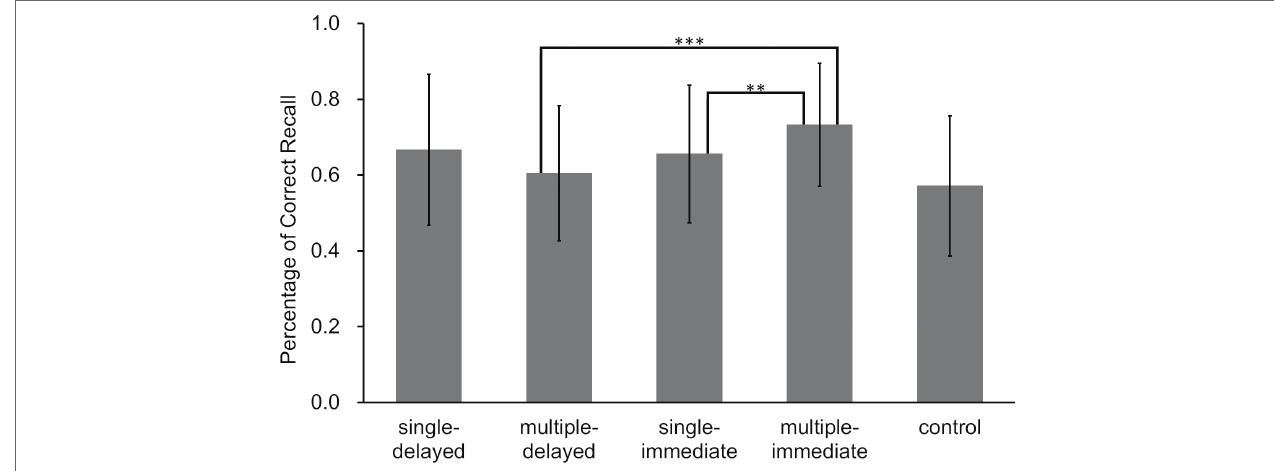
FIGURE 8 | Correct answer rates on the final tests for each learning condition in Experiment 3b (error bars represent SD ). The results of a two-factor analysis of variance on the four retrieval conditions revealed significant differences between each condition, connected by a straight line (*** p < 0.01, ** p <